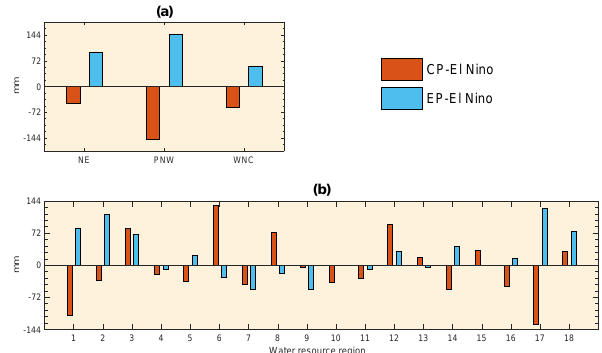
Figure 3. Domain-averaged annual runoff anomalies (unit: mm) for (a) NE, PNW, and WNC climate regions; (b) the 18WRRs, during CP- and EP-El Niño